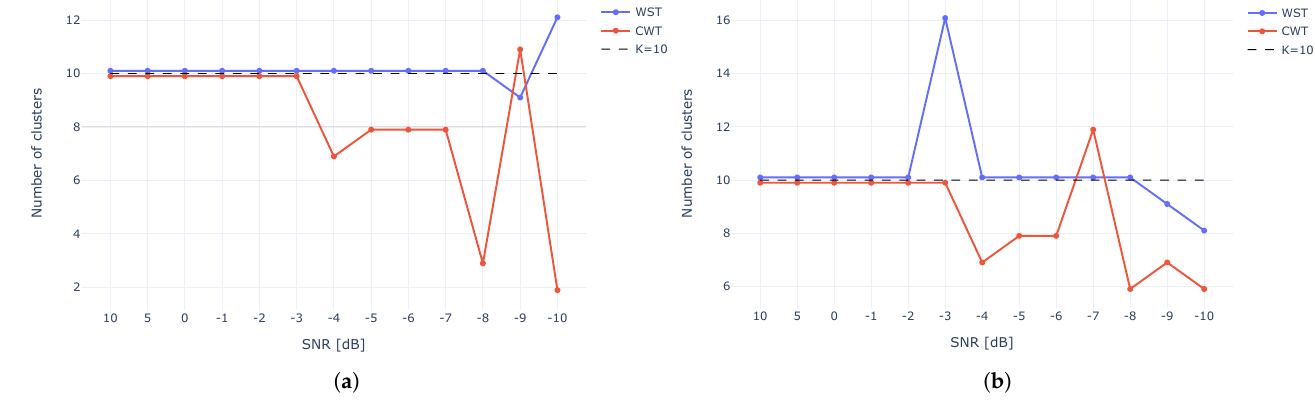
Figure 16. Number of clusters using mean-shift ( a ) and x-means ( b ) for various SNR.